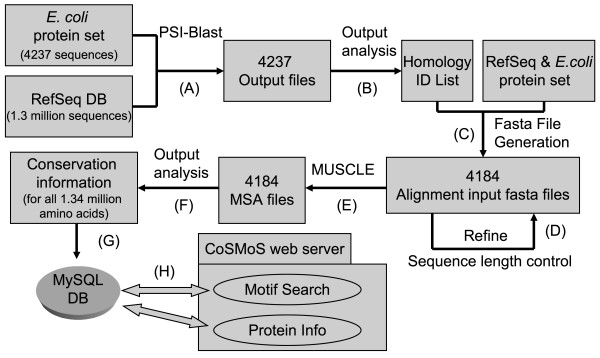
Construction of CoSMoS. PSI-BLAST was used to identify homologues of E. coli K12 proteins in the RefSeq database (A). The PSI-BLAST output was parsed (B) and used to generate a fasta file for each individual E. coli protein containing the E. coli sequence itself and all homologous sequences (C). Fasta files were edited (D) to accommodate the MUSCLE alignment (E). Multiple Sequence Alignments (MSA) were then analyzed to extract amino acid (AA) conservation information (F) that was stored along with the according protein information in a MySQL database (G). The MySQL database can be queried using the web frontend [11] (H).